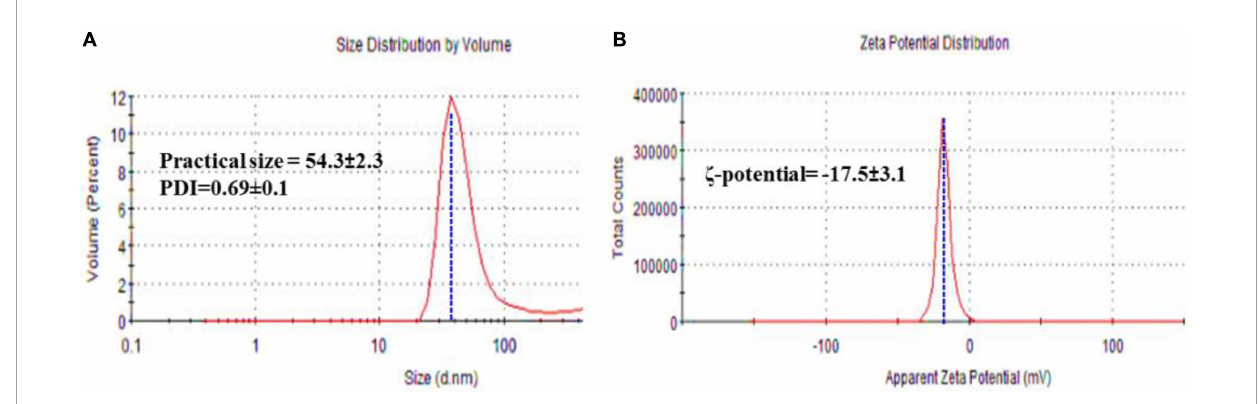
FIGURE4 (A) Hydrodynamic size, and polydispersity index (PDI); and (B) ζ -potential of FA-AgNPs. Numerical data are reported as mean ± SD ζ -potential ( n = 3) and particle size and PDI ( n =